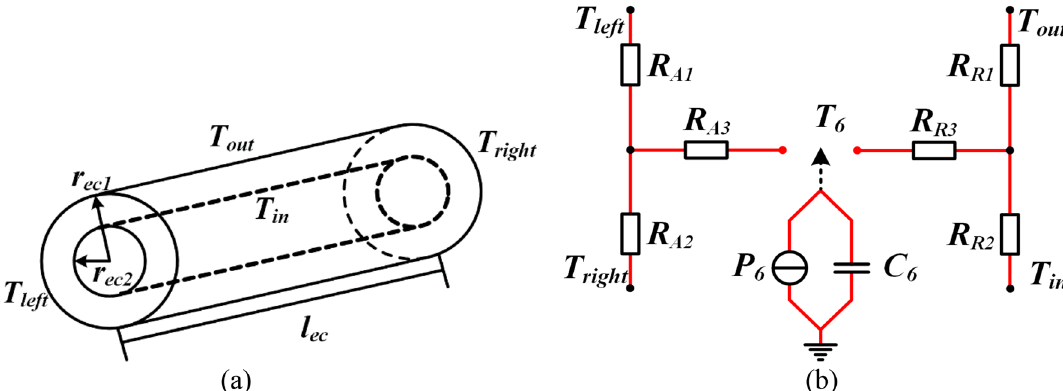
Figure 3. Excitation coil and its T-equivalent thermal circuit: ( a ) General hollow cylindrical component, ( b ) Independent axial and radial T-equivalent thermal